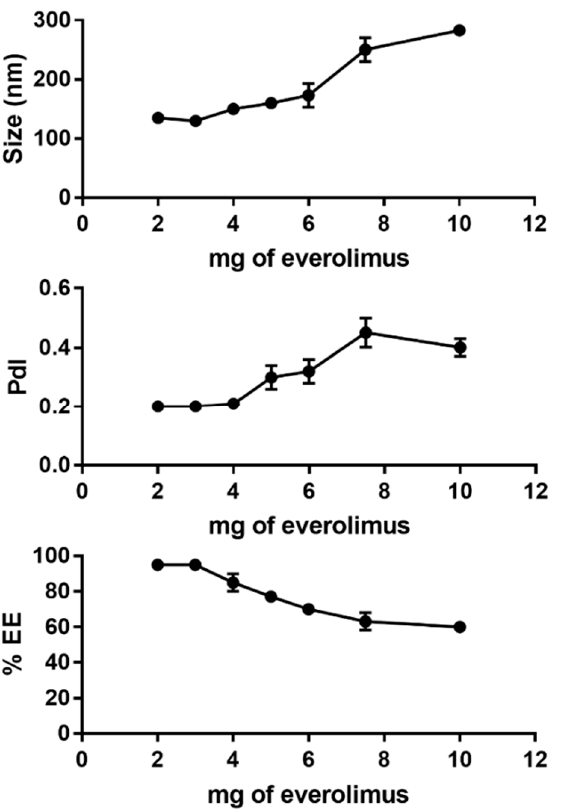
Figure 3. Variations of liposome size, PdI, and EE as a function of mg of everolimus added in the PEGylated liposome formulation.